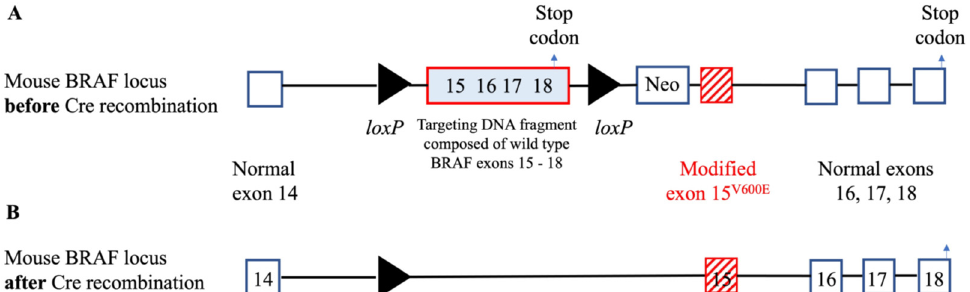
Figure 1. The BRAF knock-in mouse model: the loxP genomic structure. ( A ) In this model, the mutated version of BRAF exon 15, the one that contains the V600E mutation, was inserted into the mouse BRAF locus between exon 14 and exon 16. This mutated version of exon 15 was preceded by a floxed loxP DNA fragment containing the last four exons, 15, 16, 17, and 18, of mouse wild type BRAF. When CRE recombinase is not around, the mouse expresses the normal version of BRAF, ending transcription (see arrow). ( B ) When CRE is expressed instead, this section is cut out, and the mouse expresses the mutated version of exon 15, followed by the normal exons 16 to 18.